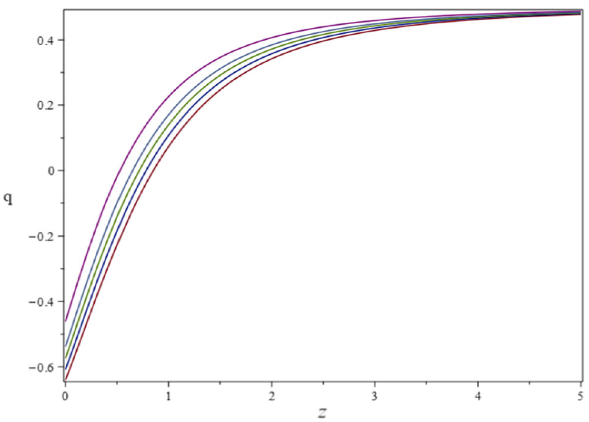
Fig. 2 The deceleration parameter as function of redshift for α = 10 2 , 10 2 . 1 , 10 2 . 15 , 10 2 . 2 and 10 2 . 5